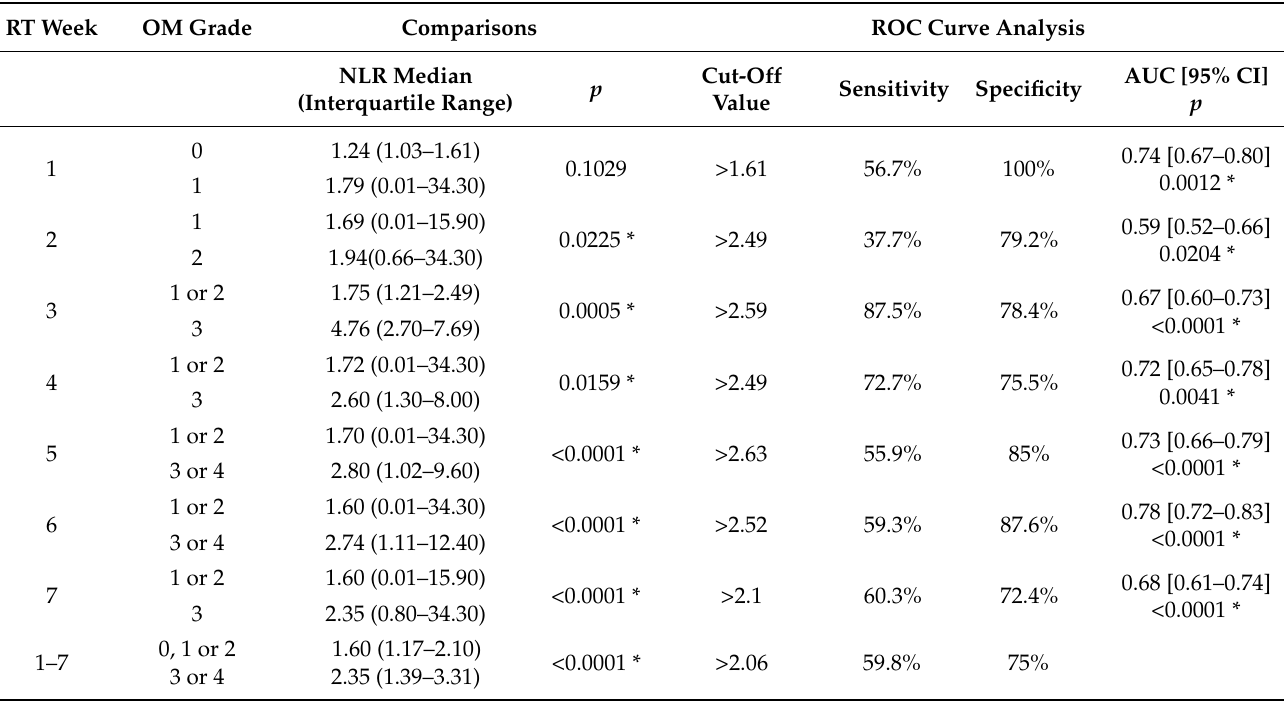
Table 2. Comparisons of NLR values according to OM grade, evaluation of diagnostic usefulness of NLR values in predicting the occurrence of more severe OM after subsequent weeks of RT.